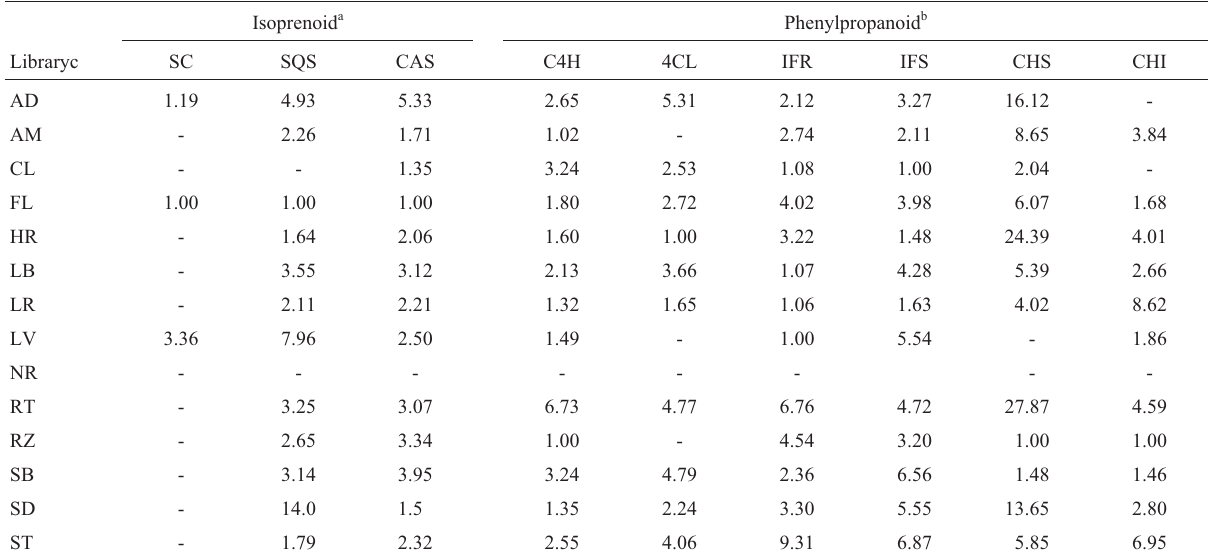
Table II - Abundance of sugarcane expressed sequence tags (ESTs) and putative isoprenoid and phenylpropanoid related enzymes. Abundance is shown as the number of enzyme related transcripts divided by the number ESTs in the